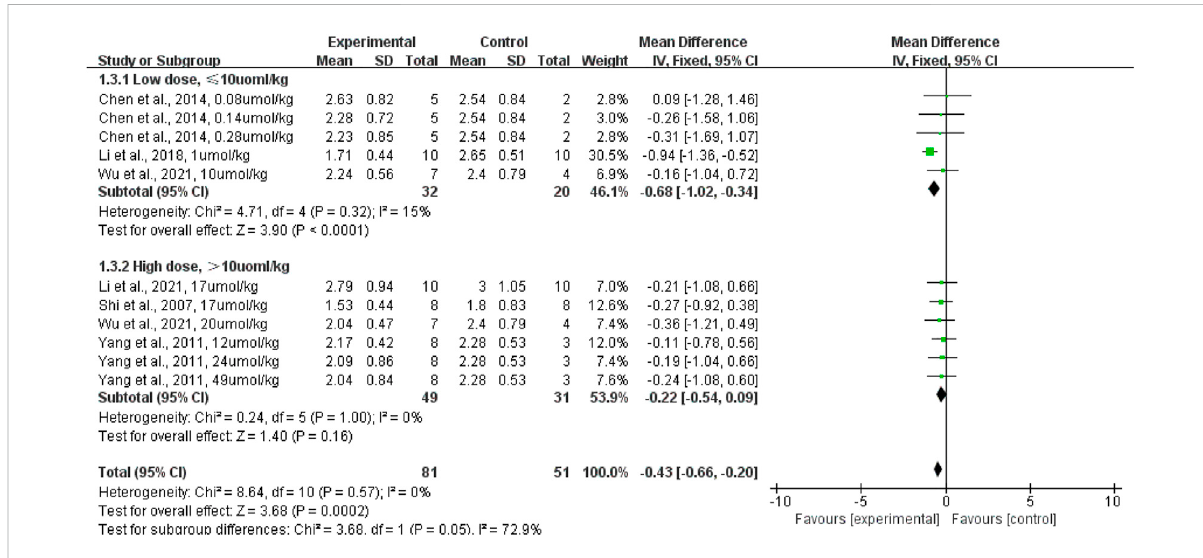
FIGURE 6 The forest plot of therapeutic ef fi ciency of terpenoid dose on lung wet-to-dry weight ratio. Subgroup analyses investigated therapeutic ef fi ciencyofhighdose( > 10 µmol/kg)andlowdose( ≤ 10 µmol/kg).CI,con fi